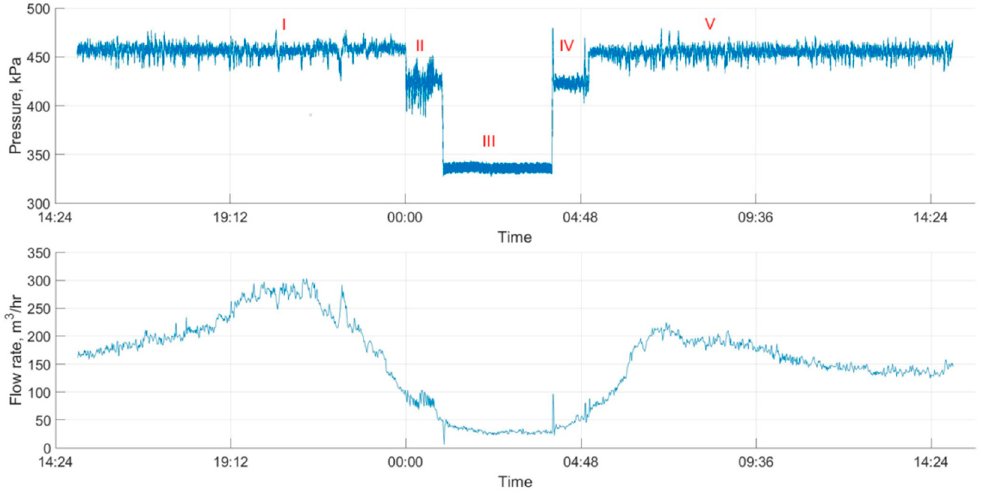
Figure 1. Daily changes in flow rate and pressure using five-stage pressure control in a selected district metered area (DMA).